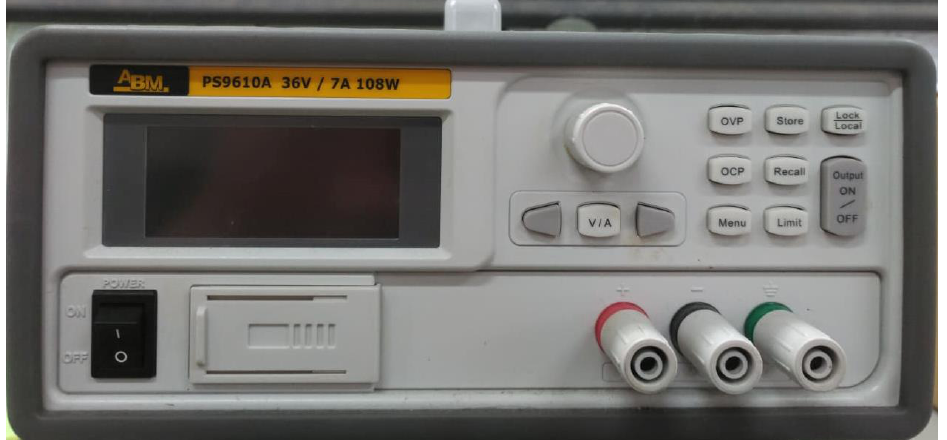
Figure 7. ABM Series Programmable Controlled Power Supply.